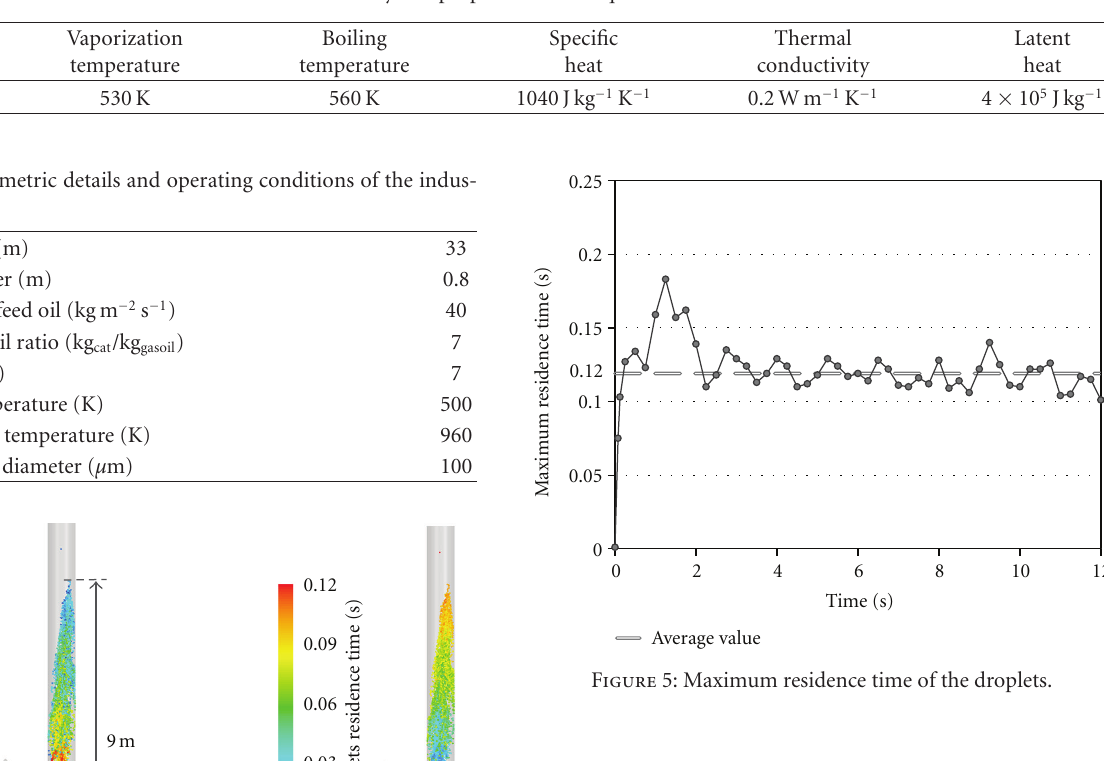
Table 5: Physical properties of the liquid feed oil.